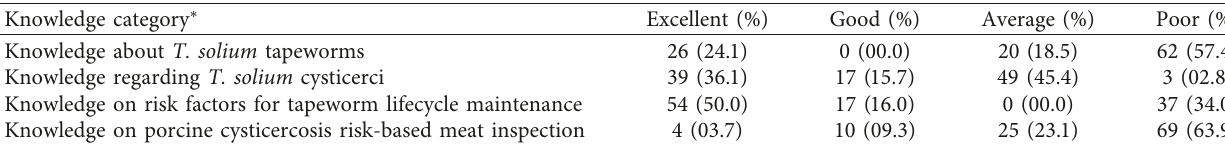
Table 5: Meat inspectors’ knowledge on T. solium cysticercosis/taeniosis and porcine cysticercosis risk-based pork carcass